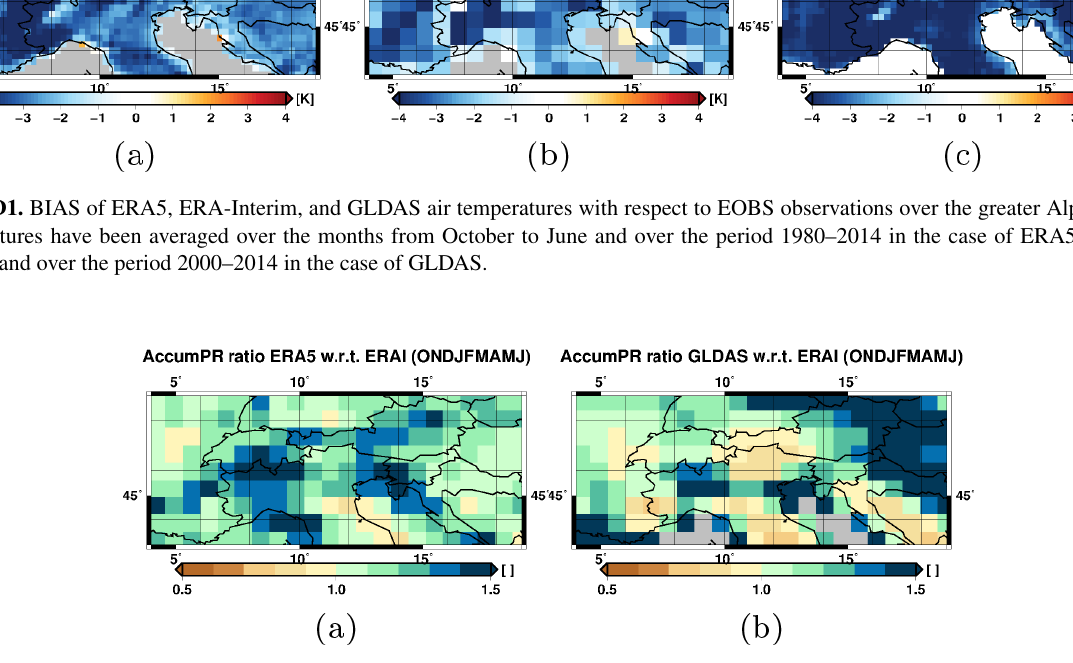
Figure D2. ERA5 and GLDAS ratios relative to ERA-Interim for the October–June accumulated precipitation over the periods 1980–2014 and 2000–2014